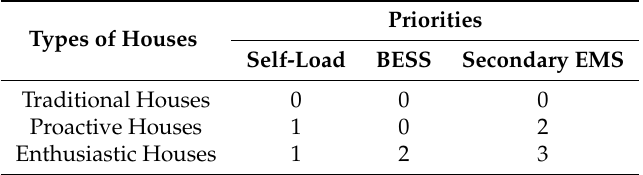
Table 3. Power sharing priorities for primary EMSs among different houses, as well as with the secondary